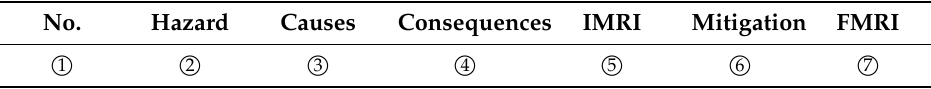
Table 2. Worksheet used for the subsystem hazard analysis. IMRI—initial mishap risk index, FMRI—final mishap risk index.